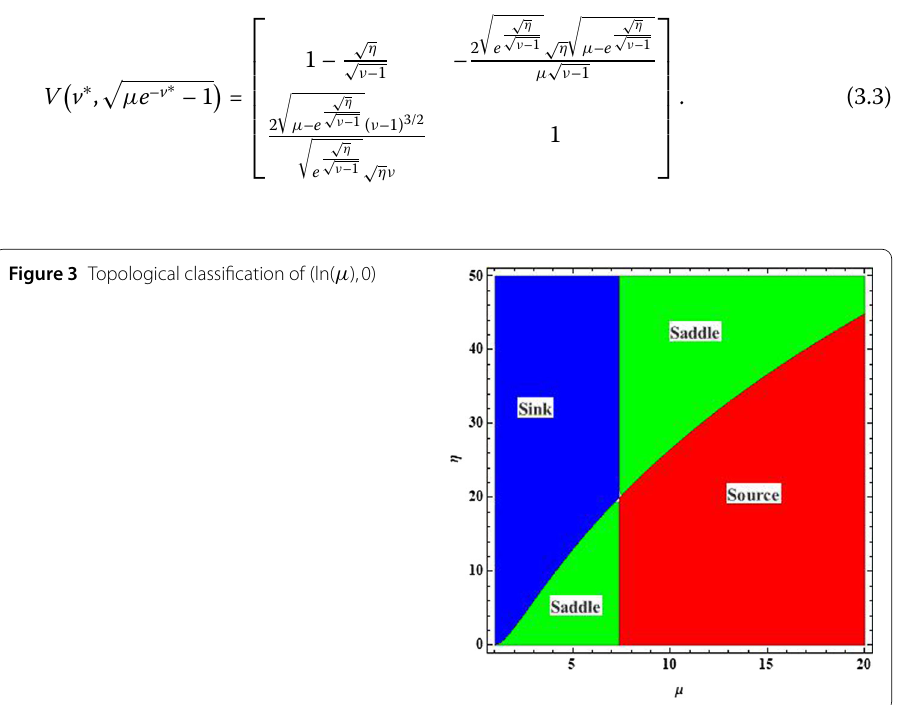
Figure 3 Topological classification of (ln( μ